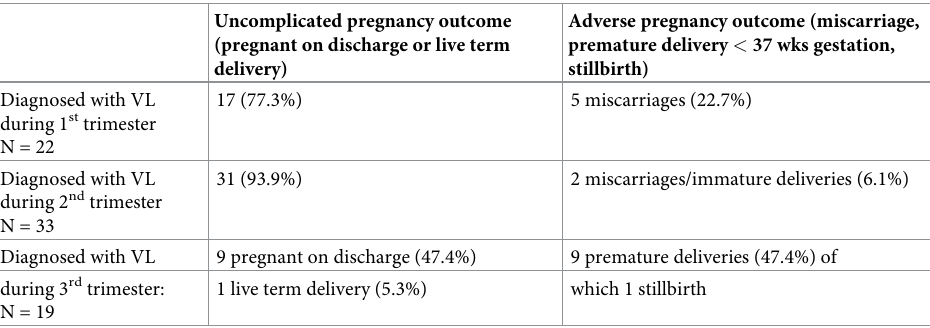
Table 5. Pregnancy outcomes per